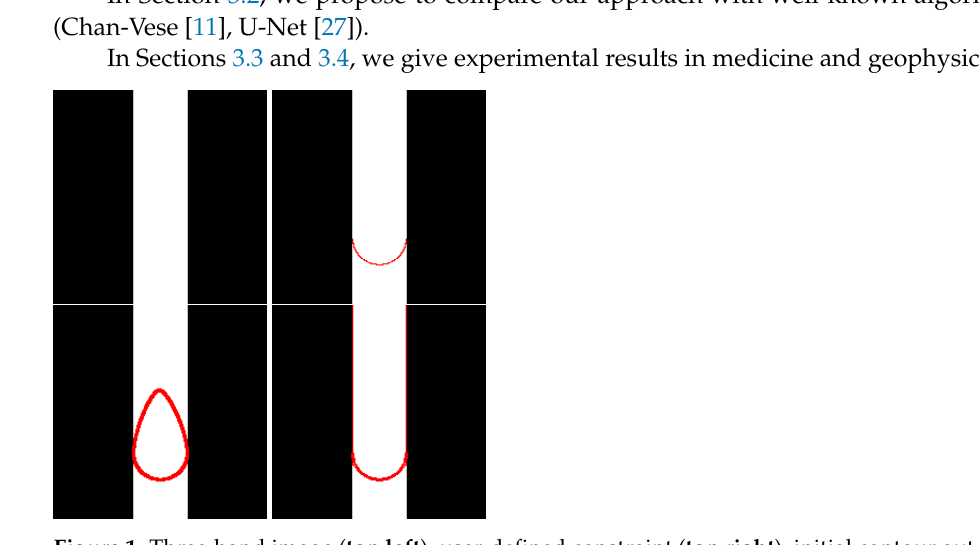
Figure 1. Three-band image ( top left ), user-defined constraint ( top right ), initial contour automati- cally defined by our approach ( bottom left ) and final contour ( bottom right